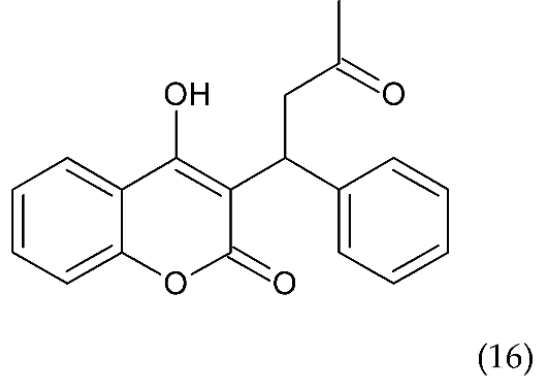
Figure 9. Chemical structure of warfarin (16).